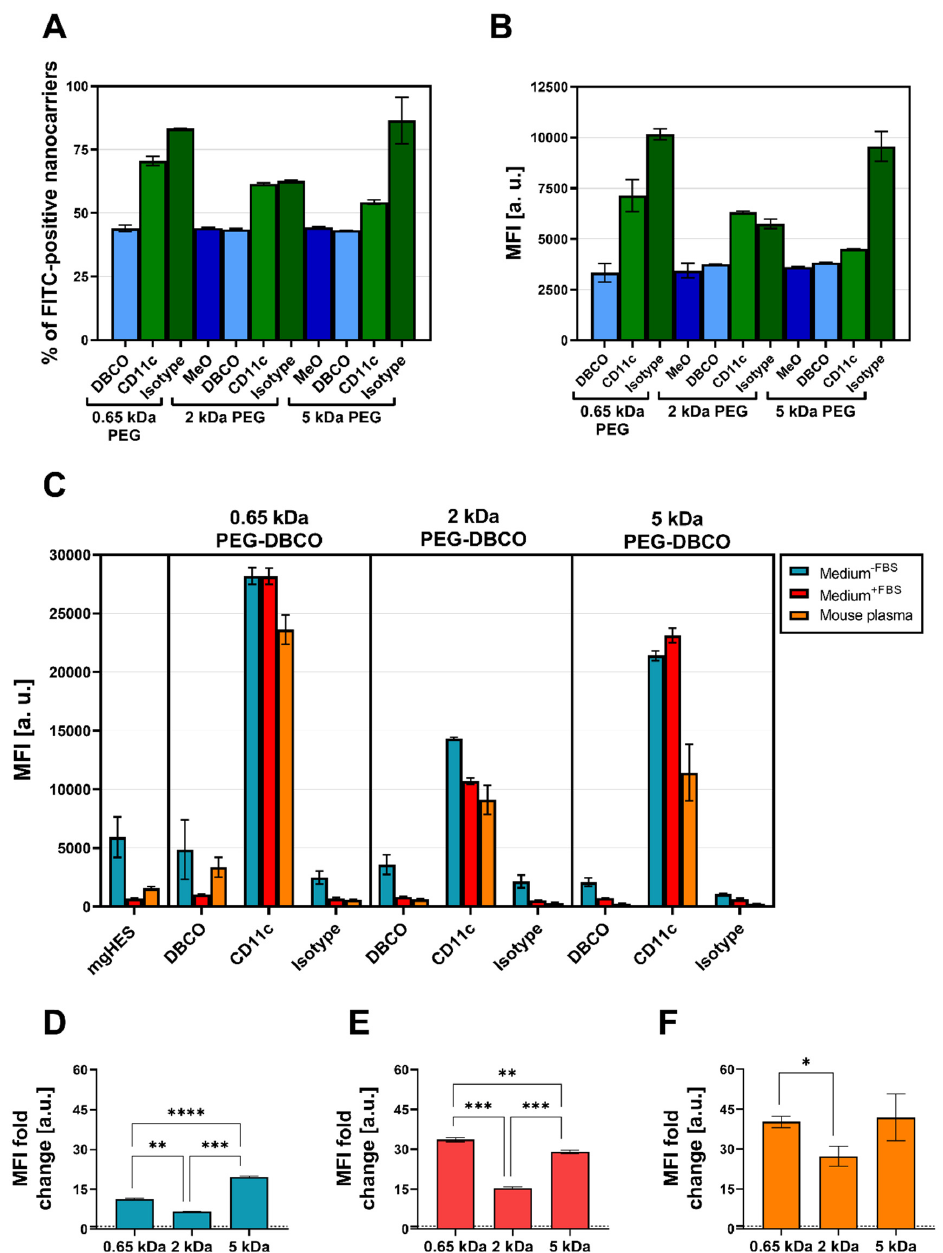
Figure 5. The PEG length affects antibody-based targeting in DC2.4 cells. Secondary antibody testing by flow cytometry qualitatively validated the presence of covalently bound antibodies on the nanocarrier surface, presented here as the percentage of positive events ( A ), and as the median fluorescence intensity [arbitrary units] (MFI [a. u.]) ( B ). Values are given as mean ± SD ( n = 2). DC2.4 cells were incubated with nanocarriers (75 µg mL − 1 ) functionalized with antibodies and PEG linkers of varying lengths (0.65 kDa, 2 kDa, 5 kDa) for 2 h in culture medium without FBS, with 5% FBS, or pre-incubated with mouse plasma, and the uptake was quantified by analyzing the MFI ( C ). Values are given as mean ± SD ( n = 3). For each cell culture medium condition, the MFI values obtained by analyzing anti-CD11c-functionalized nanocarriers were normalized to their isotype controls and different PEG linker lengths were compared (without FBS ( D ), with FBS ( E ), pre-incubated in mouse plasma ( F )). Significance was given with p < 0.05 using a Brown–Forsythe and Welch ANOVA test), p < 0.05 *, p < 0.01 **, p < 0.001 ***, p < 0.0001 ****.